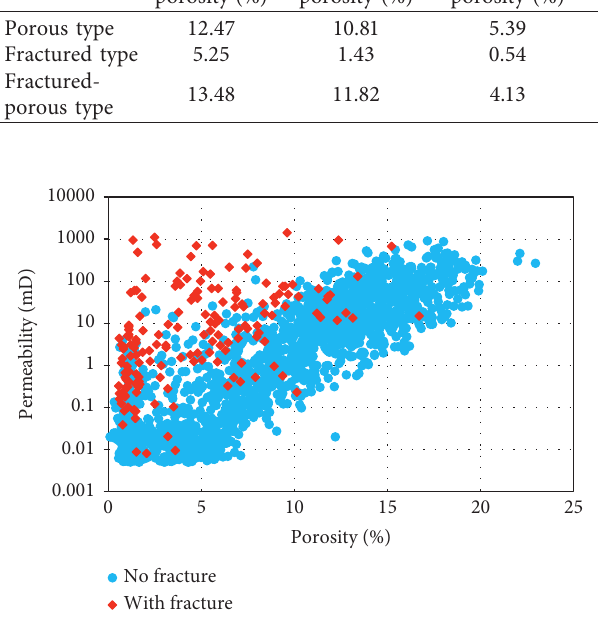
Figure 9: The relationship between porosity and permeability of